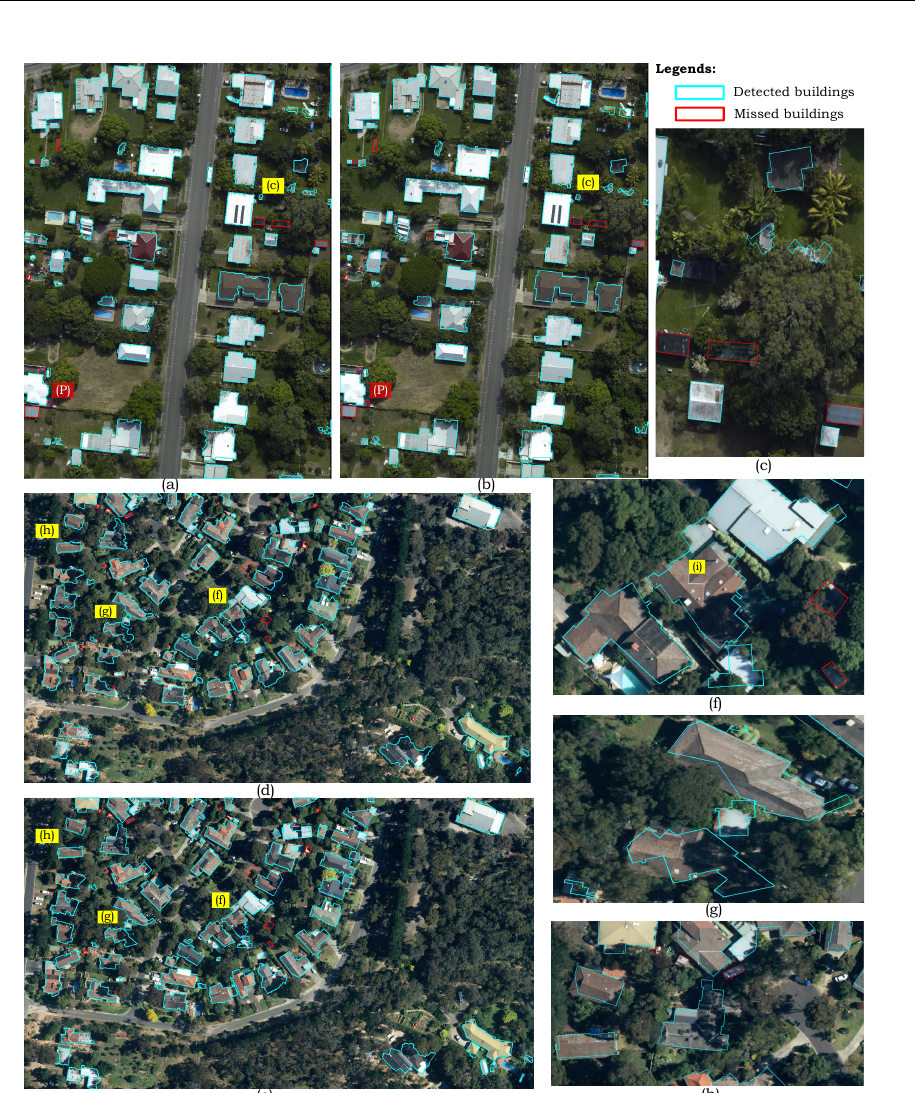
Figure 14. ( a , b ) Building detection and regularisation on AV data set; ( c ) Building regularisation example in AV; ( d , e ) Building detection and regularisation on EL data set; and ( f – h ) Building regularisation examples in EL. Areas marked in (b) and (e) are magnified in (c) and (f–h),